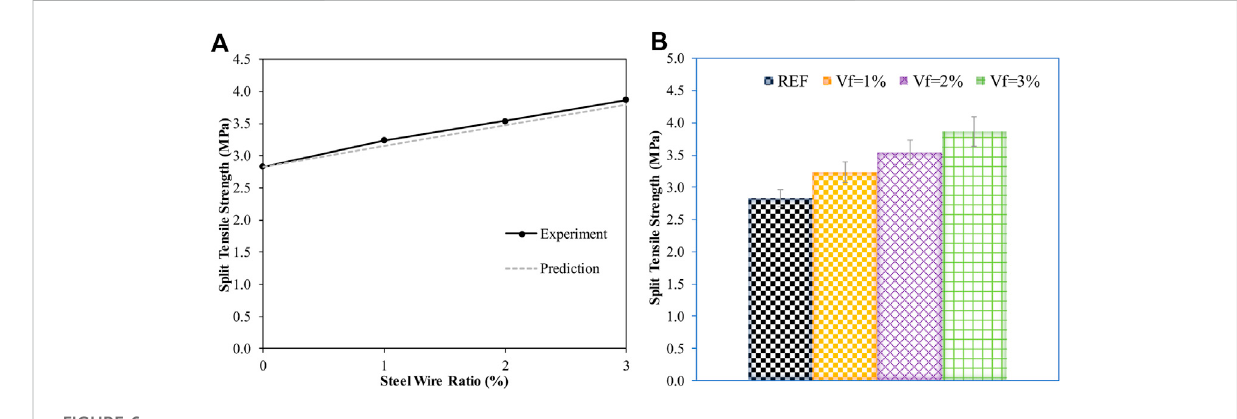
FIGURE 6 Results (A) of splitting (B) tensile strength.